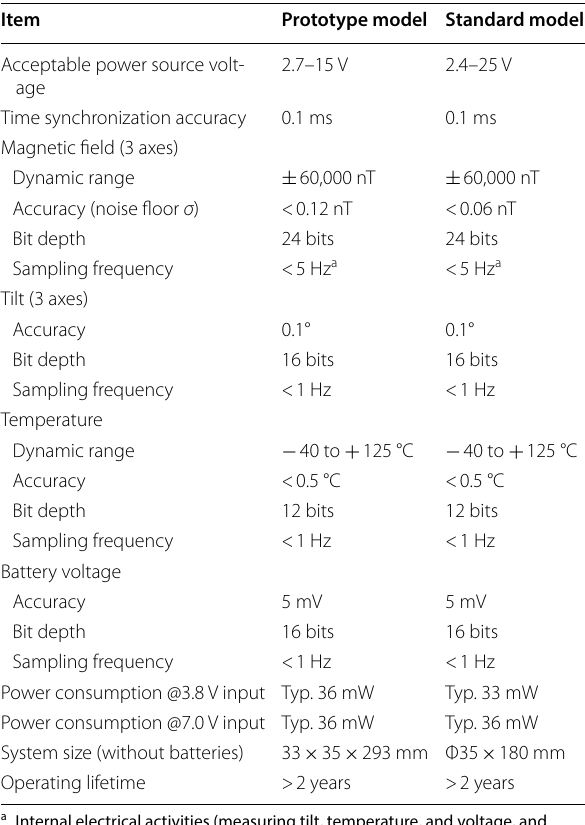
Table 1 Main specifications of the magnetometer systems for the prototype model and the standard model, which are distinguished by the type of the control